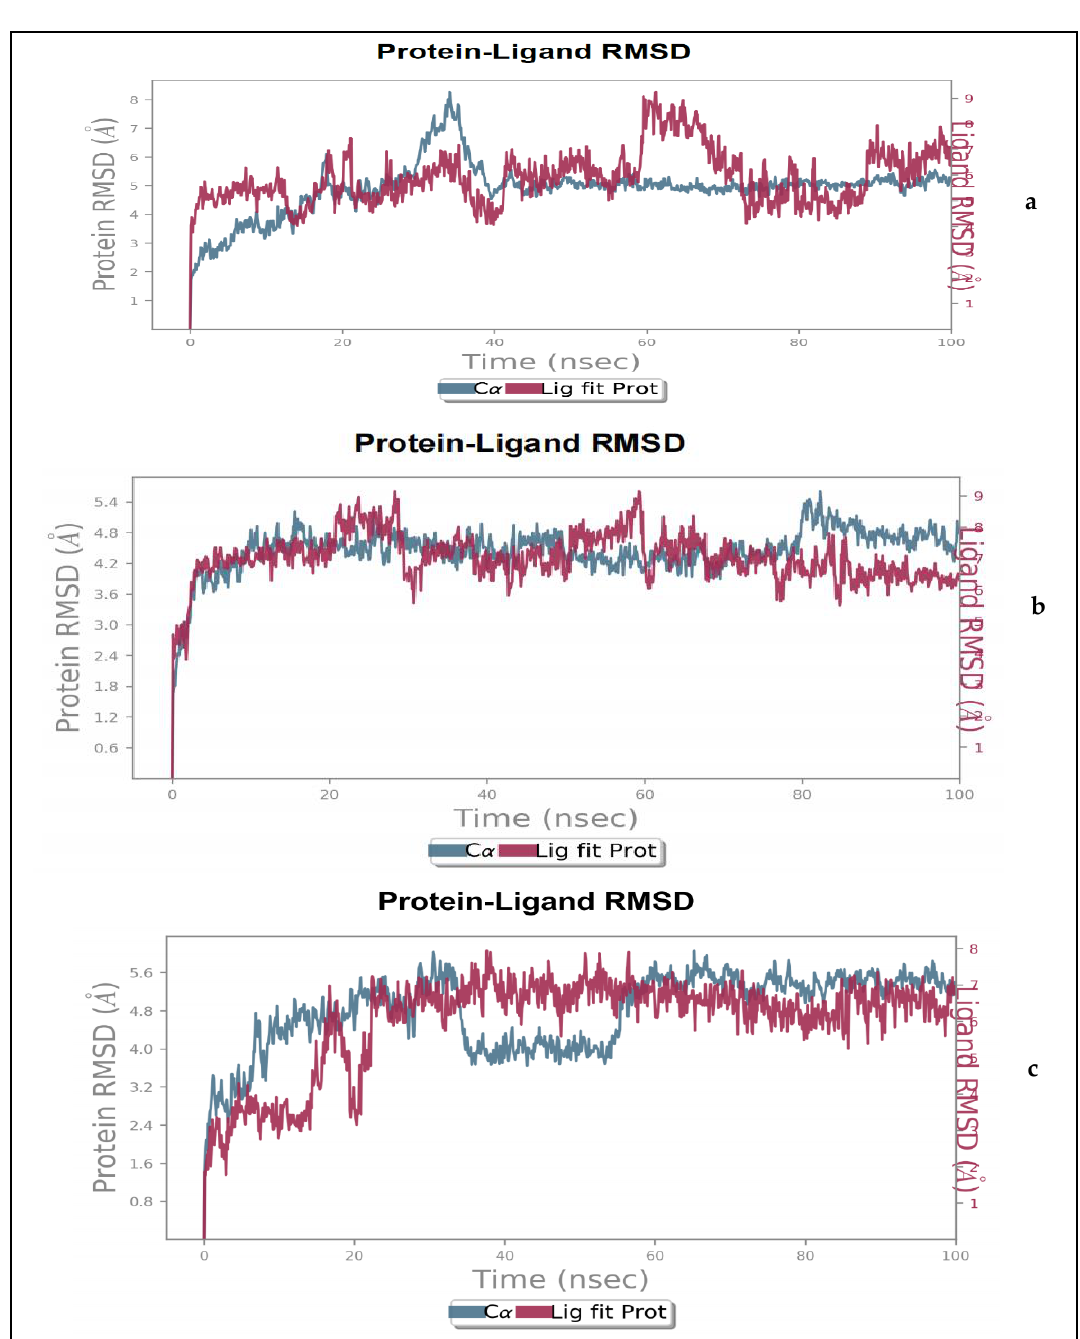
Figure 2. Protein-ligand root mean square deviation for NorA with ( a ) sinapic acid, ( b ) p-coumaric acid and ( c ) ciprofloxacin in a simulation trajectory of 100 ns.